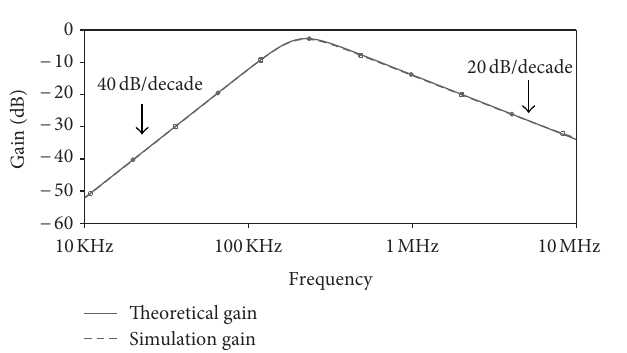
F 7: Fre�uen�� response of t�ird order uns���etri�al bandpass